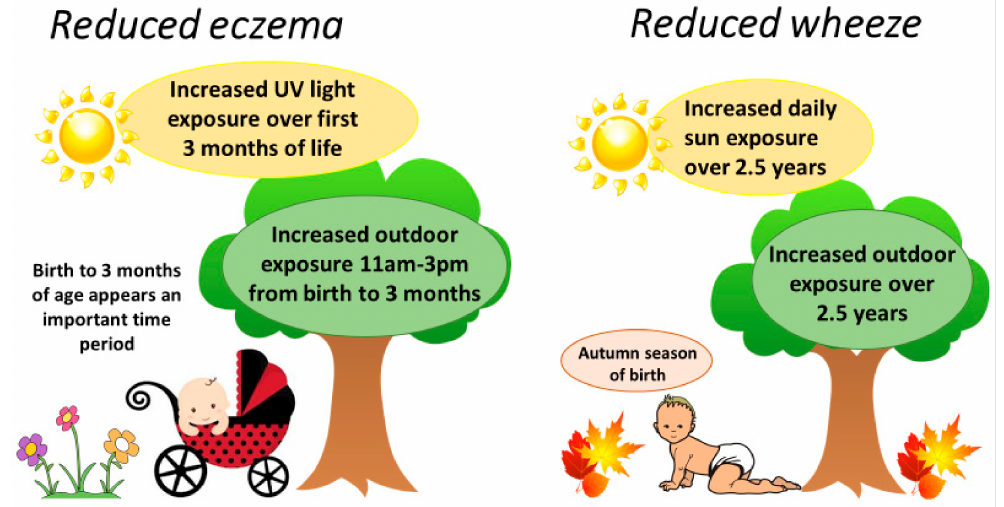
Figure 2. An illustrated summary of the major factors within the first 2.5 years of life that were associated with medically diagnosed eczema and wheeze